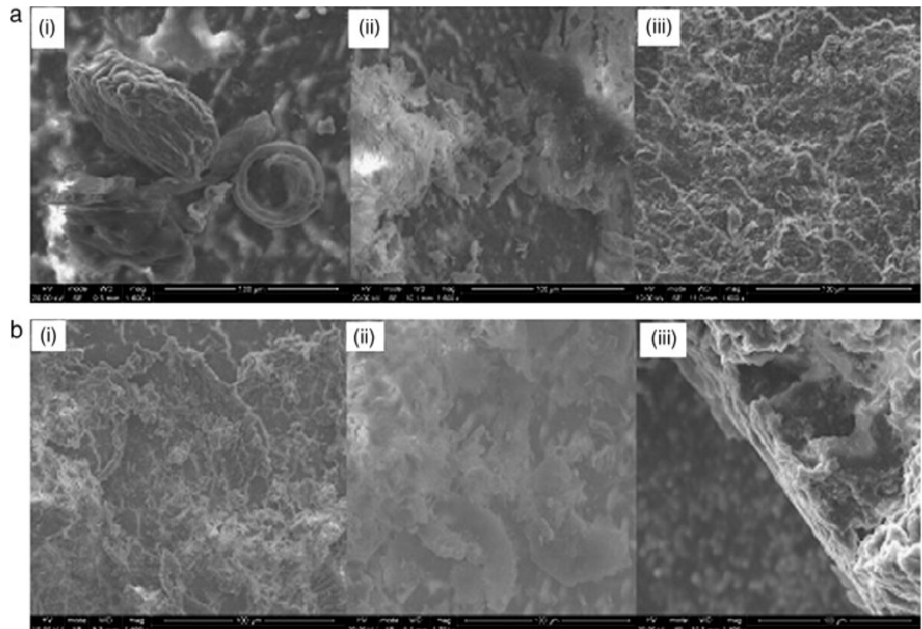
Figure 5. SEM images of polymer/fluoride-substituted HA composites-tooth interface after immer- sion for 90 days in ( a ) deionized water ( b ) artificial saliva. The images were taken after the push-out test. The concentration of fluoride-substituted HA varied i.e., ((i) 10%, (ii) 15%, and (iii) 20%) [77].